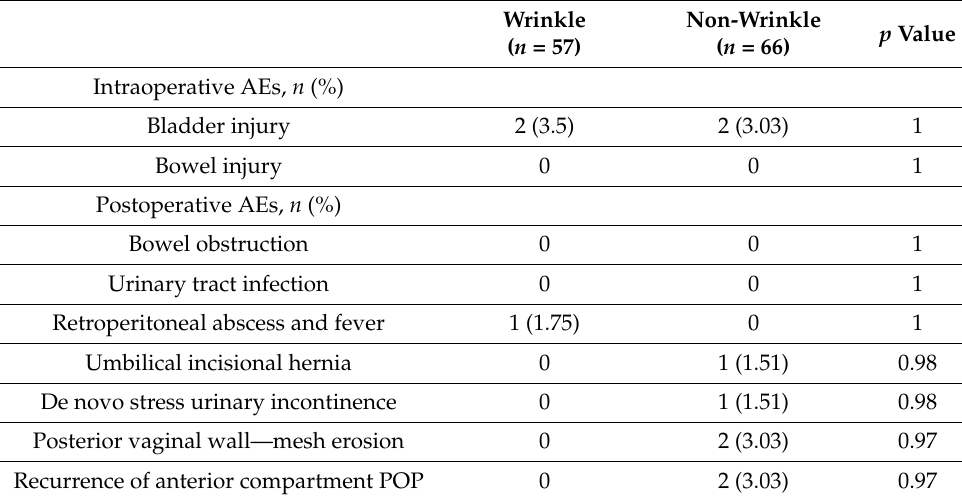
Table 3. Comparison of intraoperative and postoperative adverse